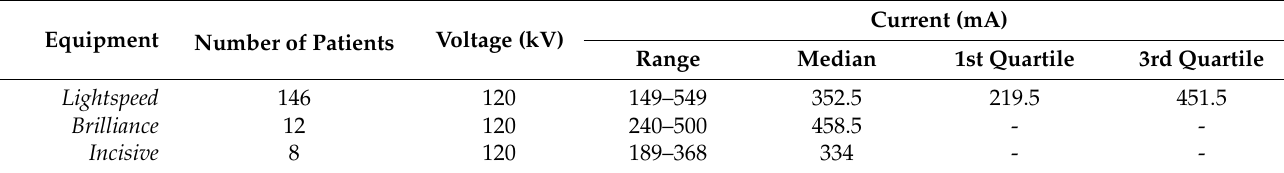
Table 1. Schematic of the CT chest present in the database based on the equipment used, the number of patients, and the voltage and current